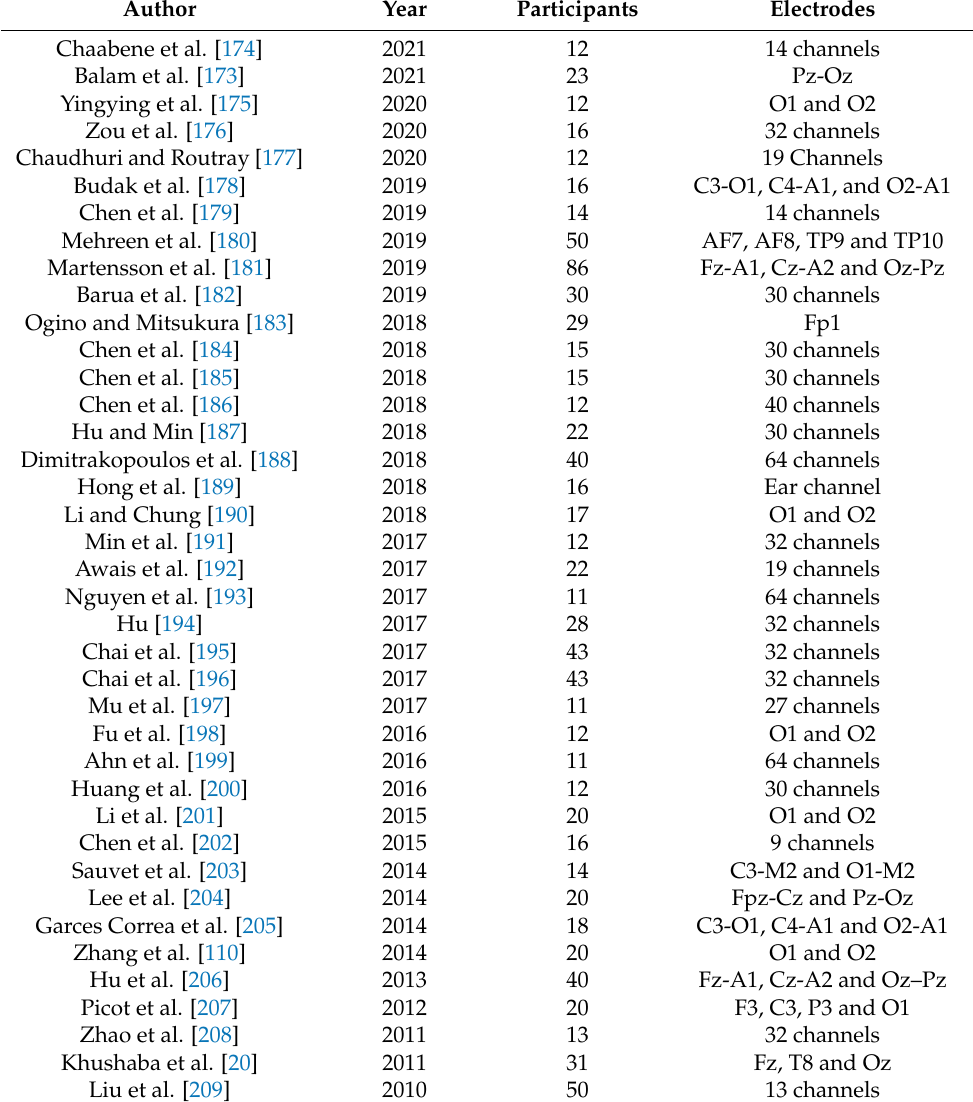
Table 3. The summary of metadata of the reviewed driver drowsiness detection